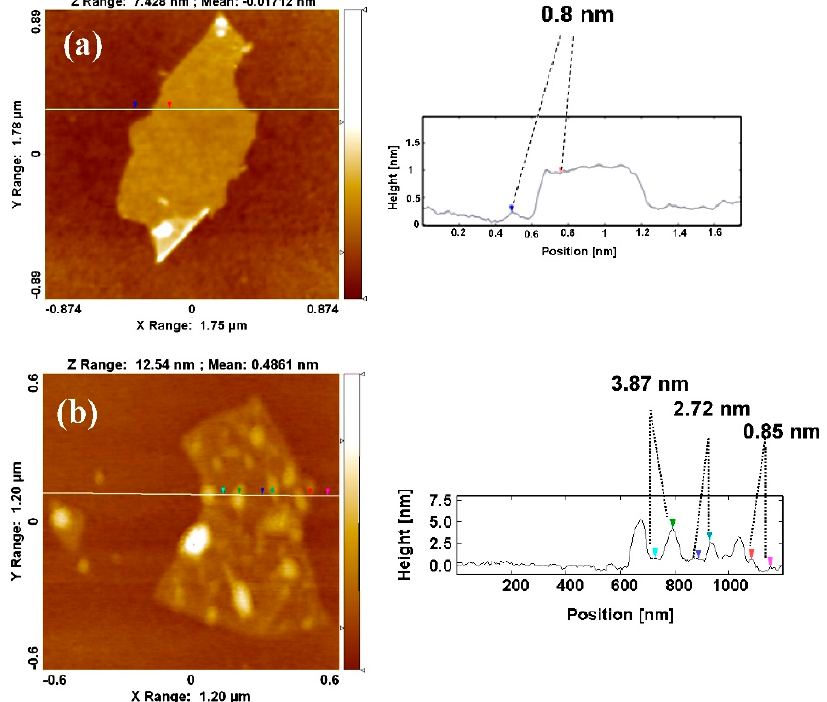
Figure 16. AFM images and height profiles of ( a ) GO and ( b ) TiO 2 /G nanocomposites. Reprinted with permission from reference [17]. Copyright 2013 Elsevier.